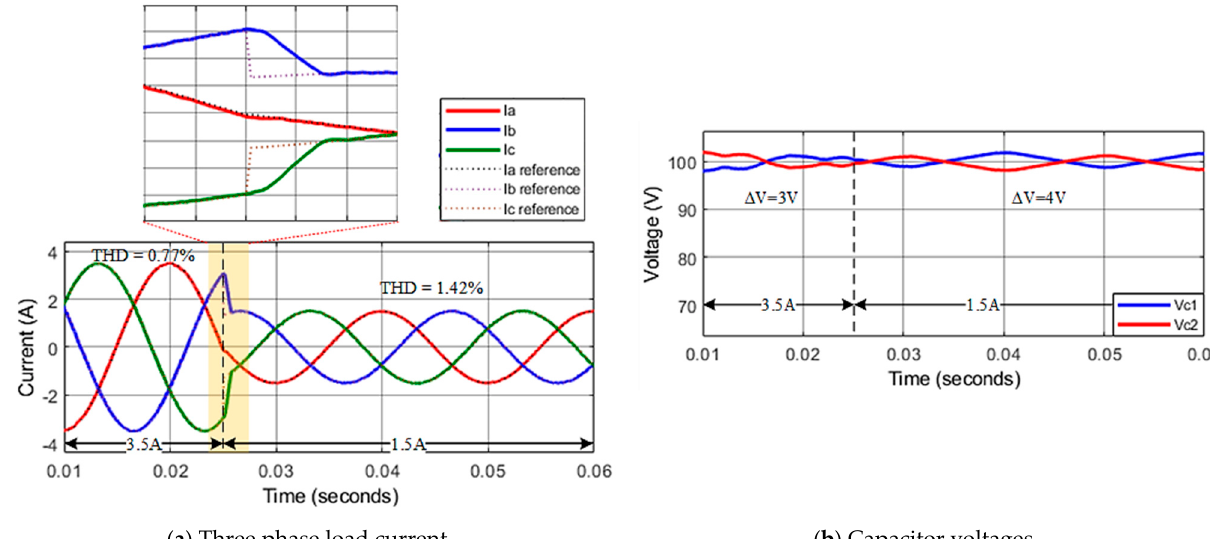
Figure 11. Transient response of asymmetric inverter using improved MPC algorithm.